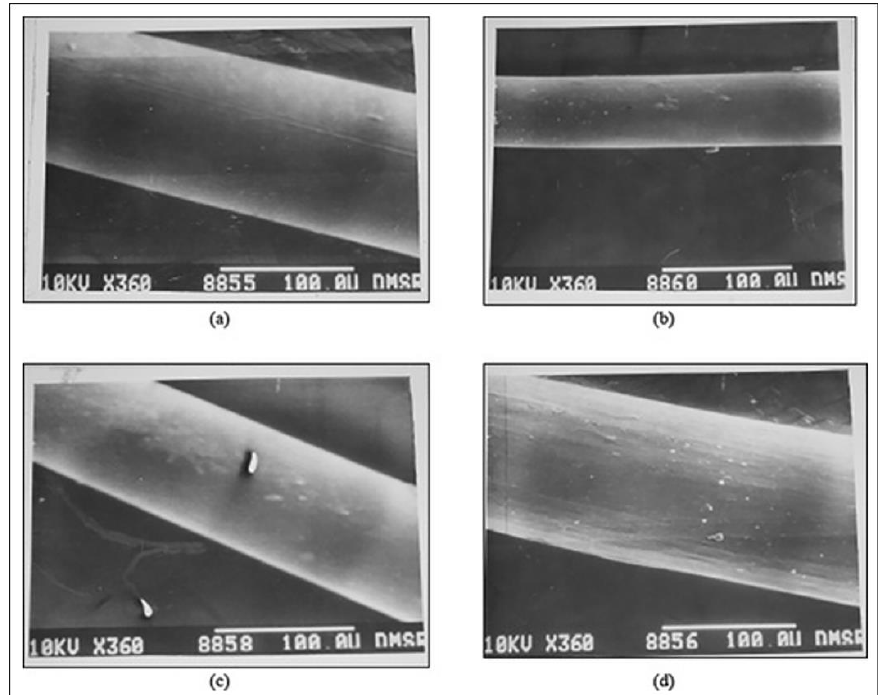
Figure 4. SEM photographs of extruded and drawn PEEK yarns at different magnifications. The photographs showed that the filament is cylindrical in shape with uniform diameter, has a smooth surface, and is transparent with no irregular striations on its surface [3]. Reproduced under the Creative Commons Attribution License from an open-access Journal of Clinical Medicine published in